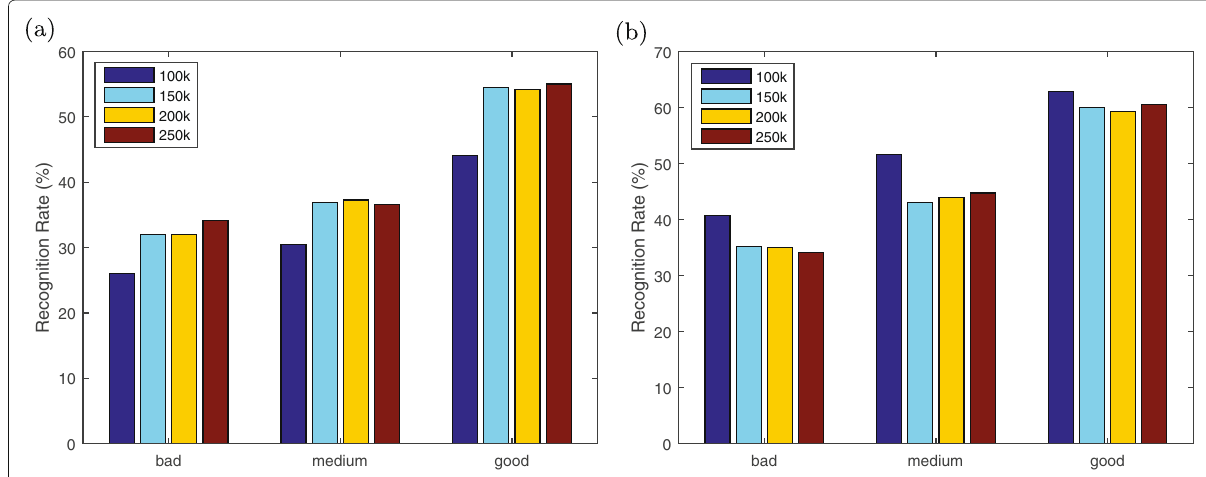
Fig. 13 Recognition performance of STIP+BSIF-TOP and iDT+BSIF-TOP on various subsets of the HMDB dataset. Bars of different colors denote the varying amount of feature descriptors (100, 150, 200, 250 k) that are sampled for codebook generation. a STIP+BSIF-TOP. b